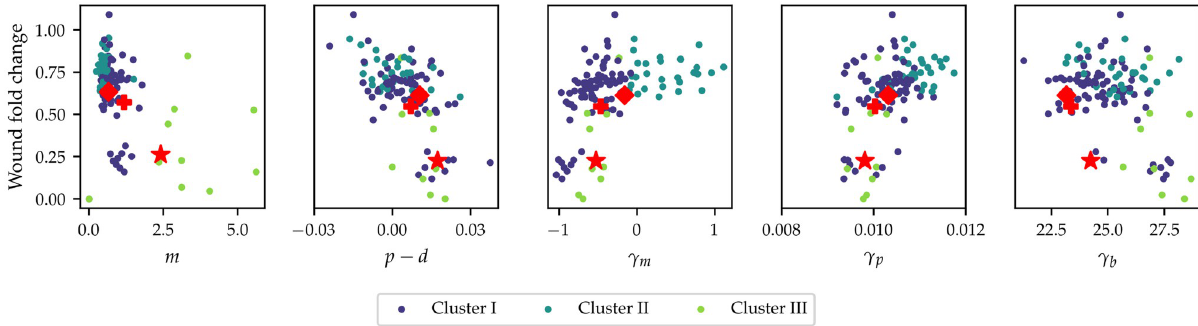
Fig 10. Observed wound area fold change plotted against the different model parameters. The colour key denotes the different clusters found using K -means clustering with K = 3. Star denotes Mock, diamond denotes CDC42 knockdown and plus denotes CDH5